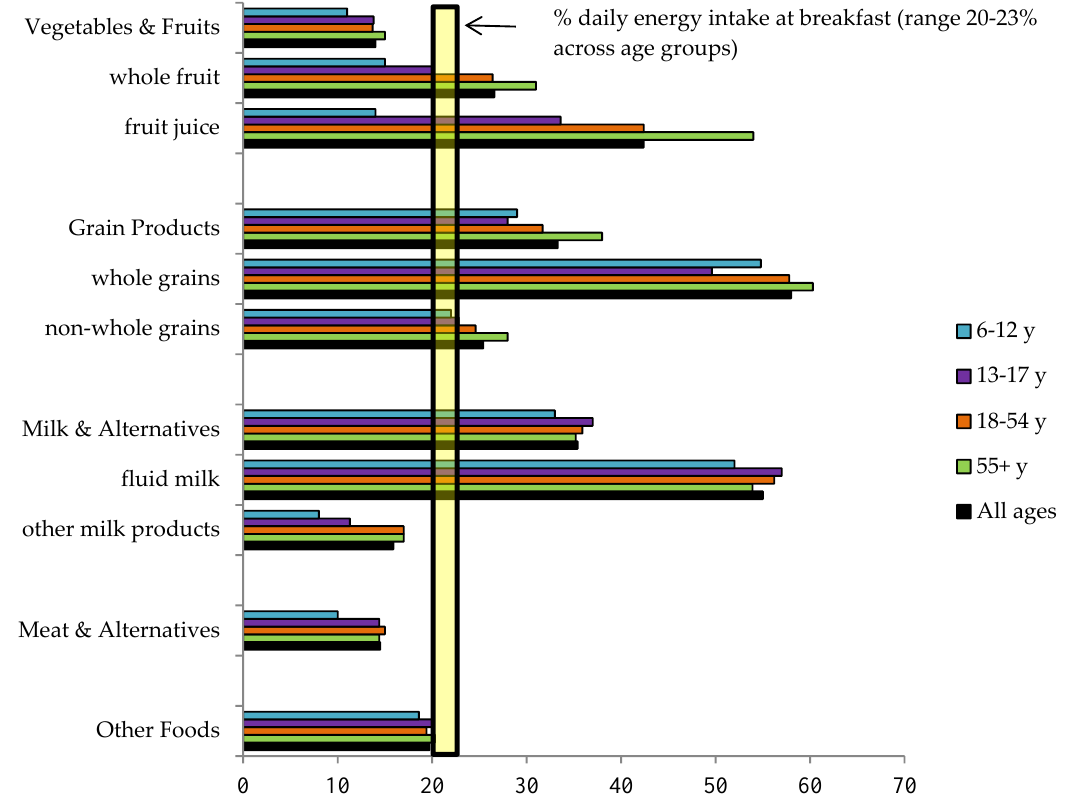
Figure 2. Contribution of breakfast to daily intakes of food groups and subgroups of Canadian breakfast consumers aged 6 years and above ( n = 16,484) by age group and for all ages